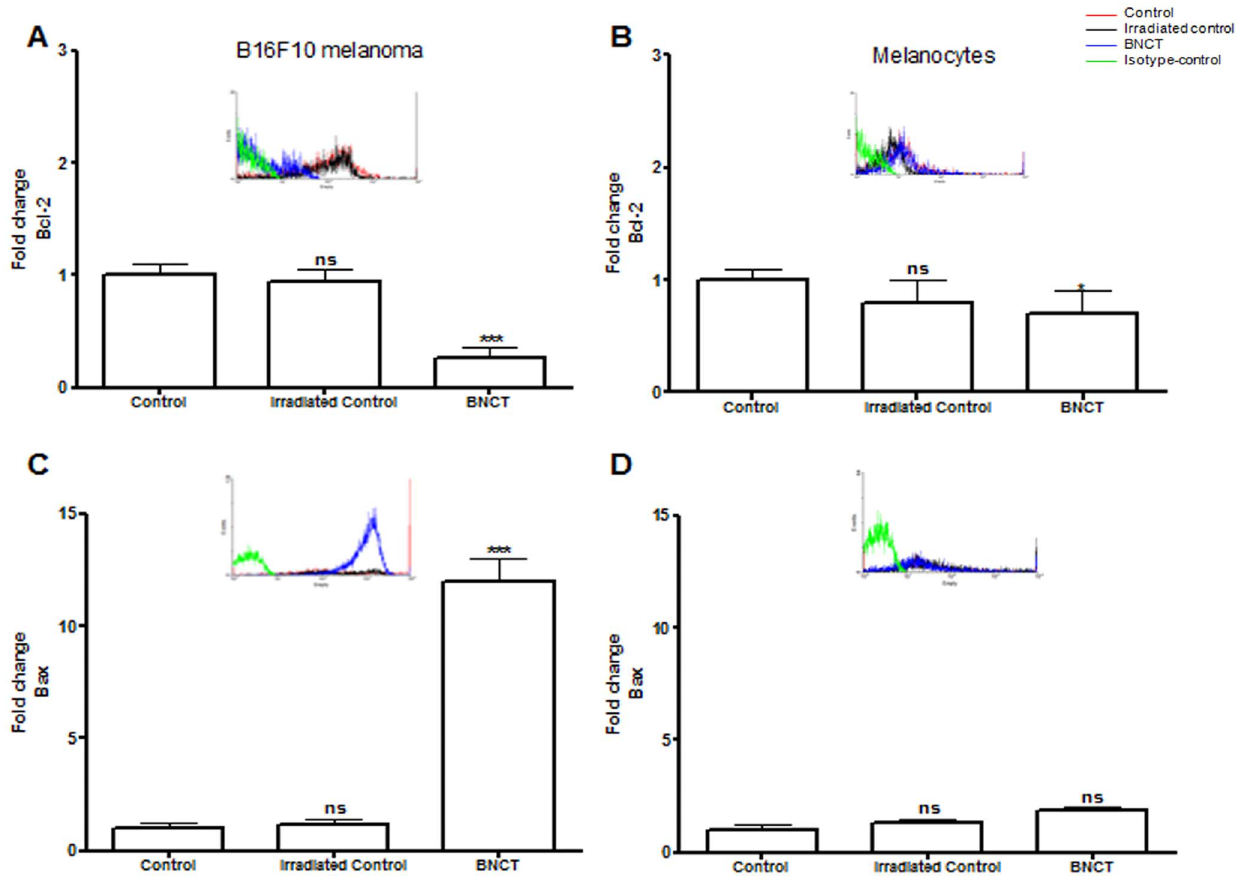
Figure 3. Expression of intrinsic apoptotic markers in B16F10 melanoma cells and normal melanocytes (mean 6 s.d.) measured by flow cytometry. (A) Expression of Bcl-2 in B16F10 melanoma cells after BNCT treatment and neutron irradiation alone (irradiated control) compared to cells without any treatment (control). (B)Expression of Bcl-2 in normal melanocytes after BNCT treatment and neutron irradiation alone (irradiated control) compared to cells without any treatment (control). (C) Expression of Bax in B16F10 melanoma cells after BNCT treatment and neutron irradiation alone (irradiated control) compared to cells without any treatment (control). (D)Expression of Bax in normal melanocytes after BNCT treatment and neutron irradiation alone (irradiated control) compared to cells without any treatment (control).Cells incubated with FITC-conjugated isotype-specific antibodies were used as negative controls. ns: not significant compared to control. *p , 0.05; **p , 0.01; ***p , 0.001 compared to